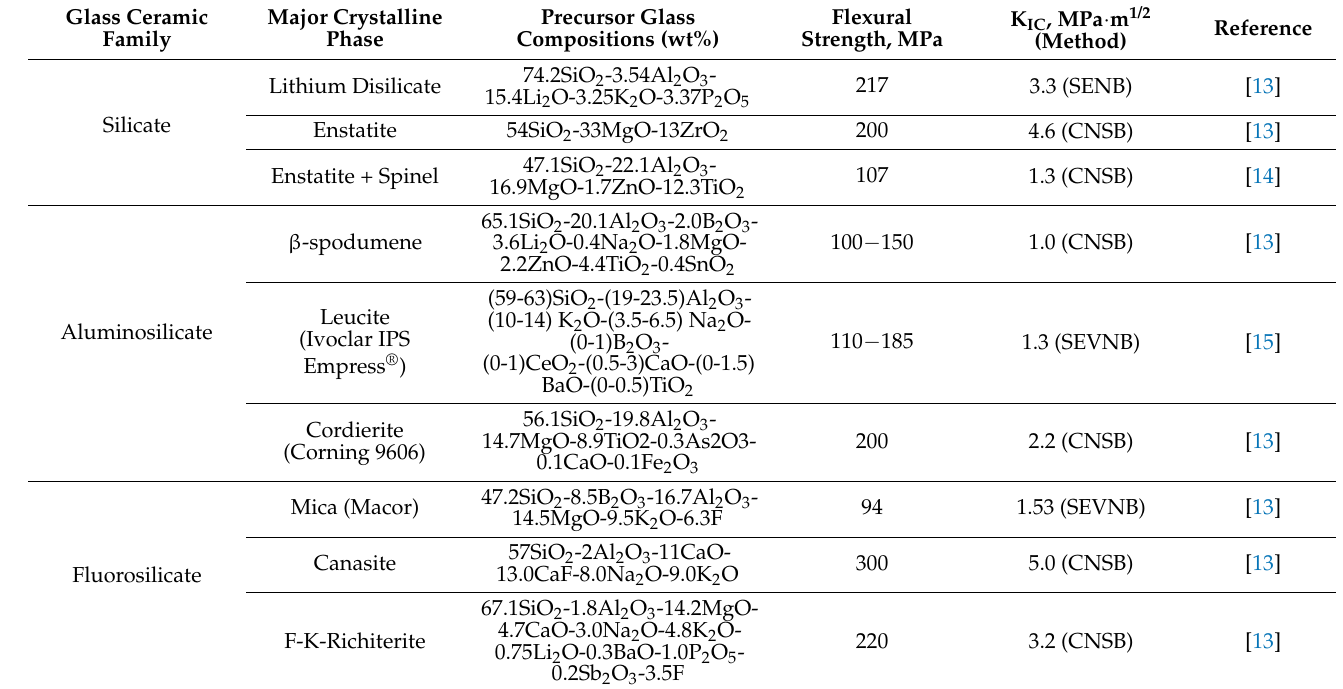
Table 1. Typical silicate, aluminosilicate, and fluorosilicate glass-ceramic (GC) compositions and properties presented in the literature